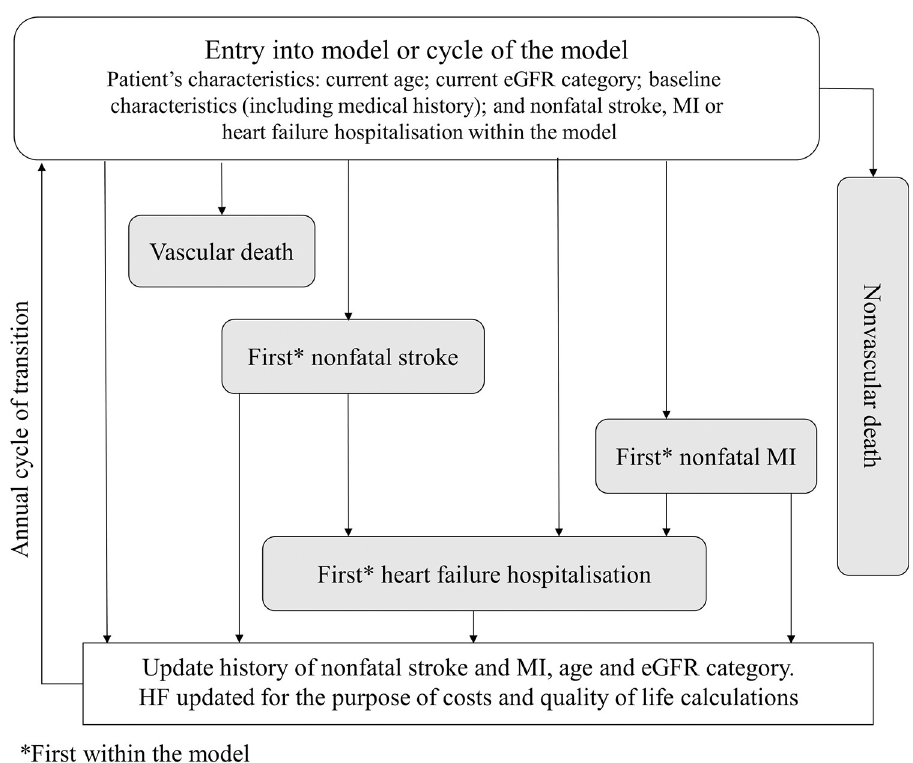
Fig 1. CVD submodel of the CKD–CVD policy model. CKD–CVD, chronic kidney disease–cardiovascular disease; CVD, cardiovascular disease; eGFR, estimated glomerular filtration rate; HF, heart failure; MI, myocardial